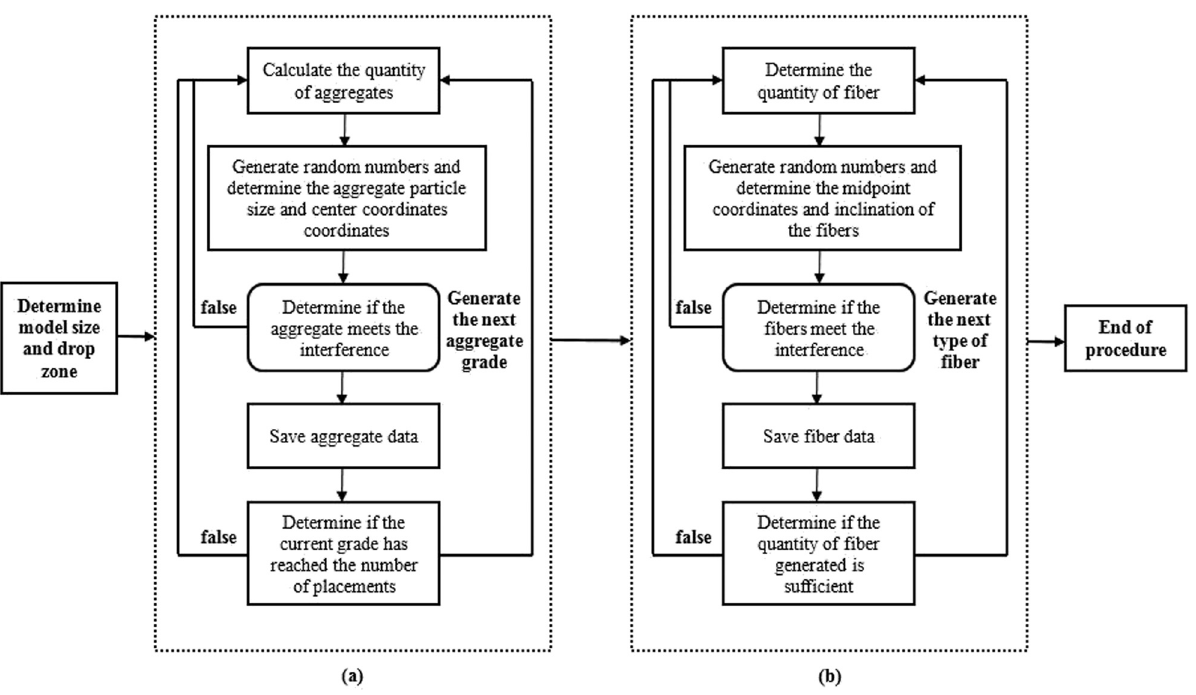
Figure 3: Procedure for random aggregate and fi ber generation. ( a ) Polygon aggregate generation process and ( b ) fi ber generation